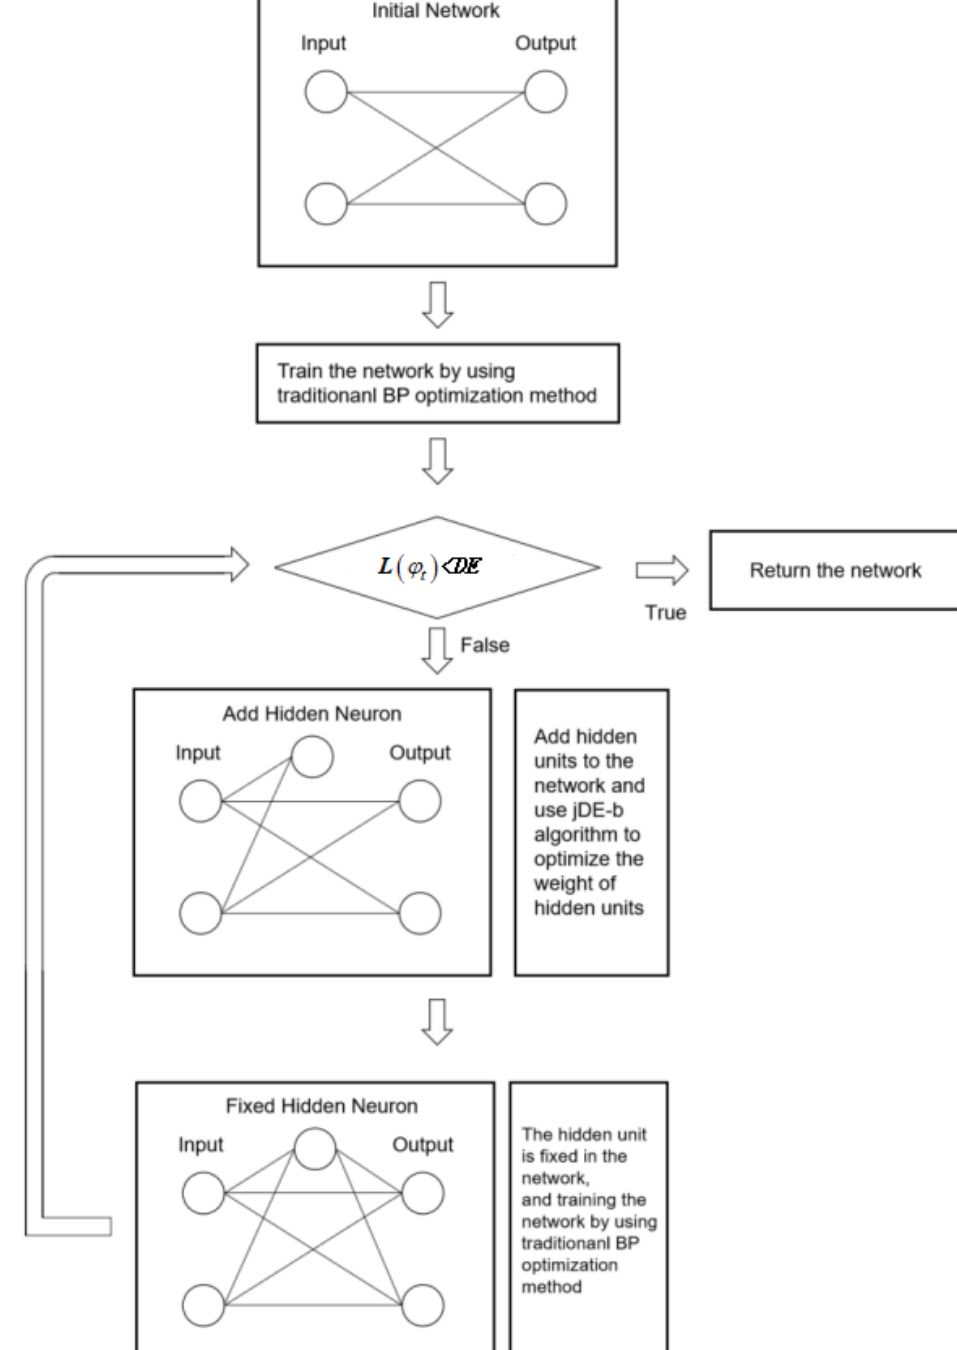
Figure 2. Steps of CCNN-jDE-B algorithm.